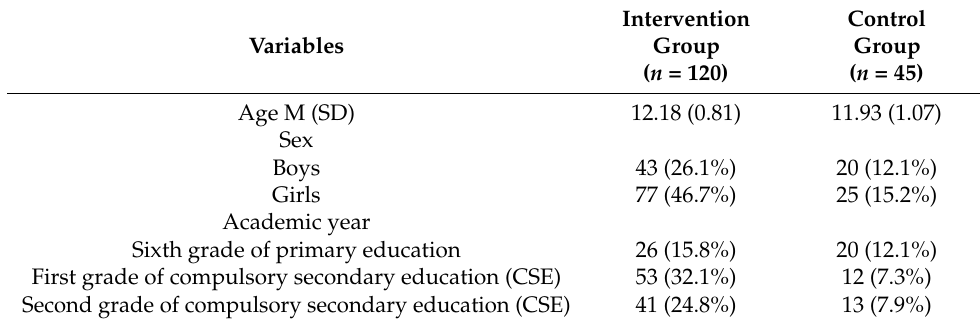
Table 1. Characteristics of the intervention and control groups by age, sex and academic year: frequency and